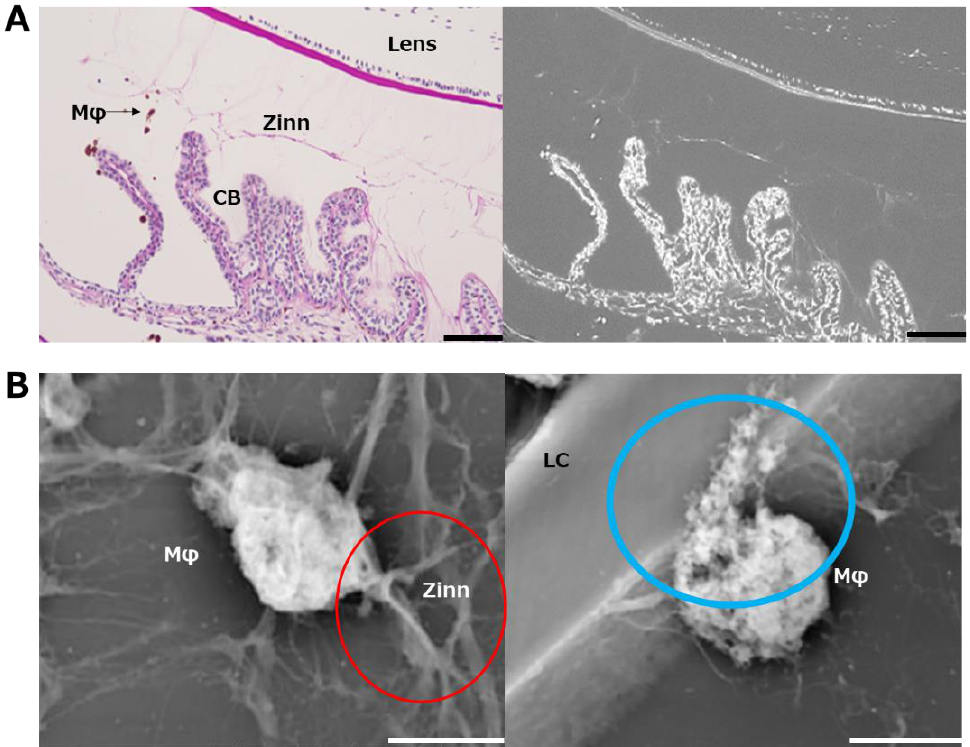
Figure 6. Ultrastructural observation of macrophages infiltrated in Zinn’s zonule using immunohistochemistry with LV-SEM. ( A ) Macrophages were labeled with ED-1. Periodic acid–Schiff (PAS) staining was used for post-staining. Areas stained with DAB are stained white by heavy metal staining in LV-SEM at 300×. Zinn’s zonule and other tissues are also stained white. Zinn: Zinn’s zonule, CB: ciliary body. Scale bar: 100 μm. ( B ) Macrophages were observed under LV-SEM at 10,000 × . Zinn’s zonule and macrophages, which are difficult to distinguish at low magnification, become distinguishable at higher magnification due to the color density and contrast. In the red-circled area, a macrophage is observed pulling on Zinn’s zonule. In the blue-circled area, a macrophage is observed to be caving into the lens capsule. Zinn: Zinn’s zonule, LC: lens capsule. Scale bar: 5 μm.